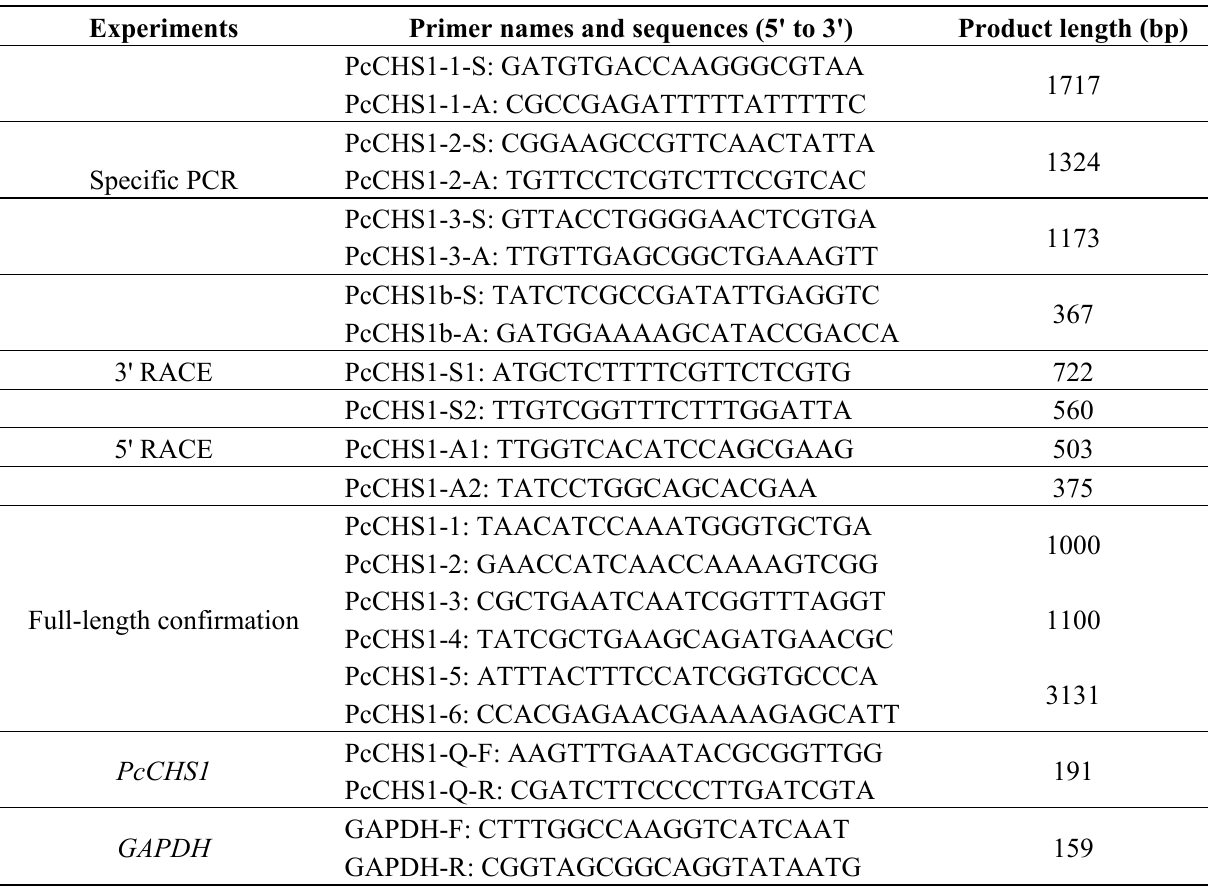
Table 2. Primer sequences used for cloning and quantitative real-time PCR.